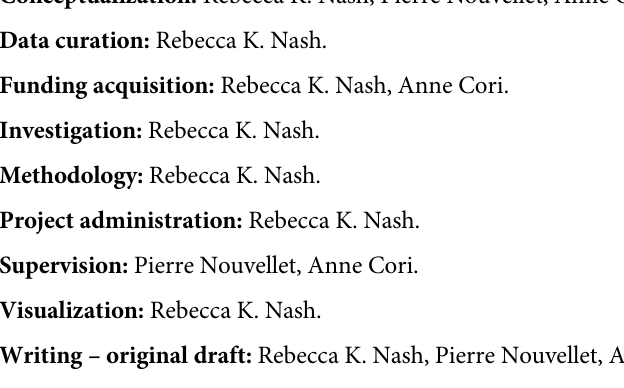
Table A. Summary table of the papers identified that used an unmodified version of EpiEstim ( n = 242). Table B. Usability of each R package or tool � identified in the scoping review. This table shows a full breakdown of how the classifications (very good = ✓✓ , good = ✓ , poor = ✗ ) were determined for the “additional exploration” section of Table 2 within the main text. For the ‘ease of installation’ and ‘documentation and tutorials’ sections, each criterion was allo- cated a score, shown in squared brackets, and the overall classification was determined by the sum of the scores. For the ‘speed’ section, each author used the system.time() function in R to determine the run time of the main function of the package available in the provided examples. �� The classification ( < 10s = ✓✓ , > 10s – 5min = ✓ , > 5min = ✗ ) was decided based on the time category agreed on by at least 2 out of the 3 computers. Figure B. Map showing the coun- try in which each questionnaire respondent is based. The majority of responses were from the USA ( n = 4), followed by Canada ( n = 2), France ( n = 2) and Indonesia ( n = 2). There was one response from each of Austria, Bermuda (circled), Germany, India, Peru, Uruguay, and the UK. Figure C. A) The profession of each questionnaire respondent and B) the purpose of their analysis. Respondents could select more than one answer for both questions. Figure D. A) Dis- ease(s) investigated by each respondent. B) Categories of input data. Respondents could select more than one answer for both questions. Figure E. Broad reason for the use of EpiEstim. Respondents could select more than one answer for this question. Figure F. Questionnaire responses to A) how well the package met the needs of each respondent on a scale from 1 to 5 (1: “badly”, 5: “very well”), and B) “Which features do you think could be improved?”. Table C. Summary of the issues and suggestions reported in questionnaire feedback categorised by broad theme. n is the number of respondents and % is the percentage of the 17 respondents who reported or made a suggestion regarding the